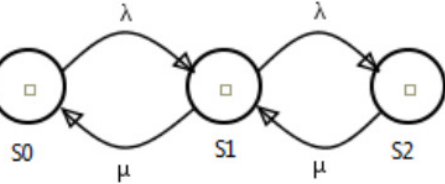
Figure 8. Example of a Continuous Time Markov Chains (CTMC)